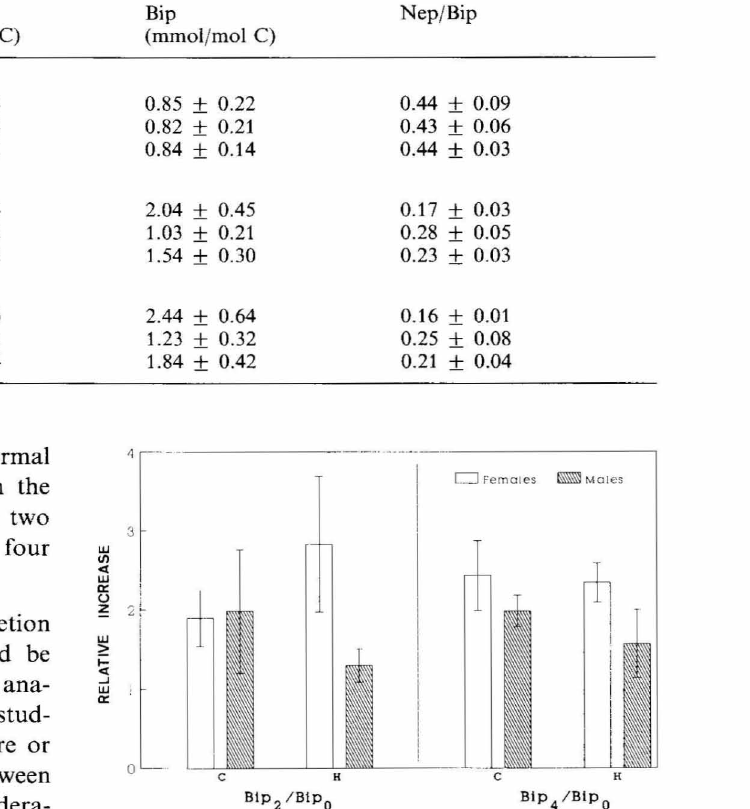
Table 2. Nep and Bip concentrations in urine and Nep/Bip ratio (mean ± SE) in PKU heterozygotes, before and after a Phe load (100 mg/kg). C, creatinine. n Nep (mmol/mol C) Before load Females 4